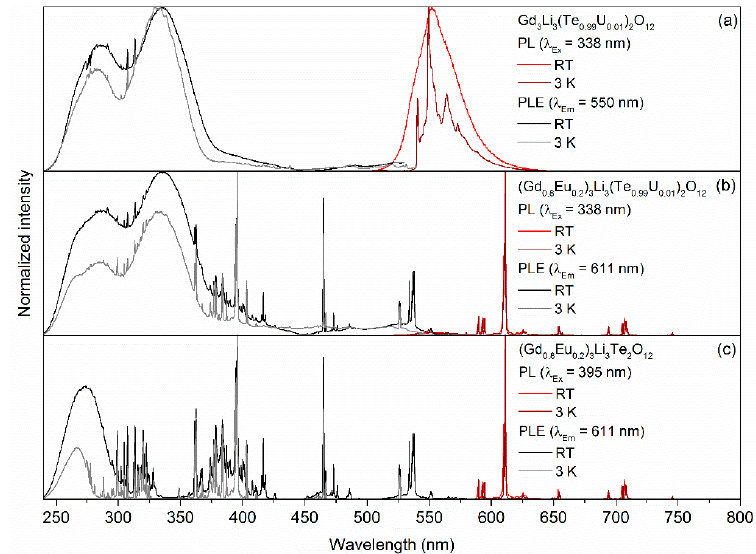
Figure 7. Emission and excitation spectra of ( a ) Gd 3 Li 3 (Te 0.99 U 0.01 ) 2 O 12 ; ( b ) (Gd 0.8 Eu 0.2 ) 3 Li 3 (Te 0.99 U 0.01 ) 2 O 12 ; and ( c ) (Gd 0.8 Eu 0.2 ) 3 Li 3 Te 2 O 12 at room temperature and 3 K.